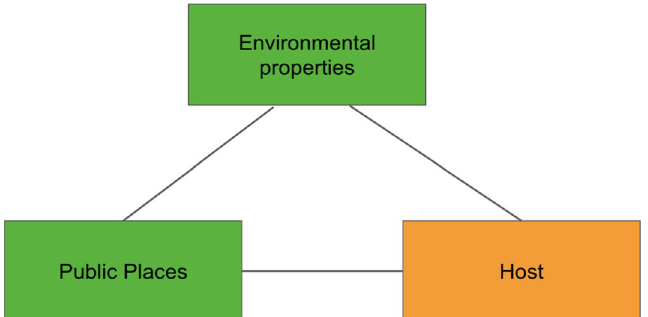
Fig. 4 Epidemiological triangle (ET)